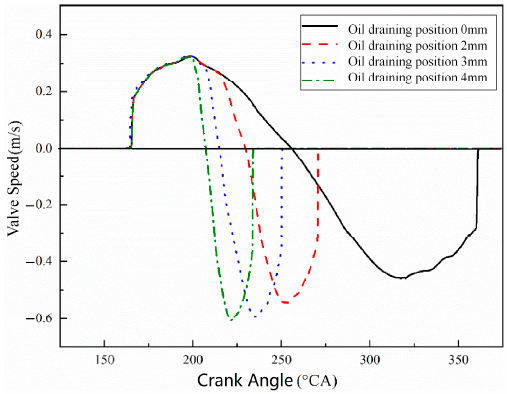
Figure 5. Valve velocity curves with different time of early ‐ releasing oil.